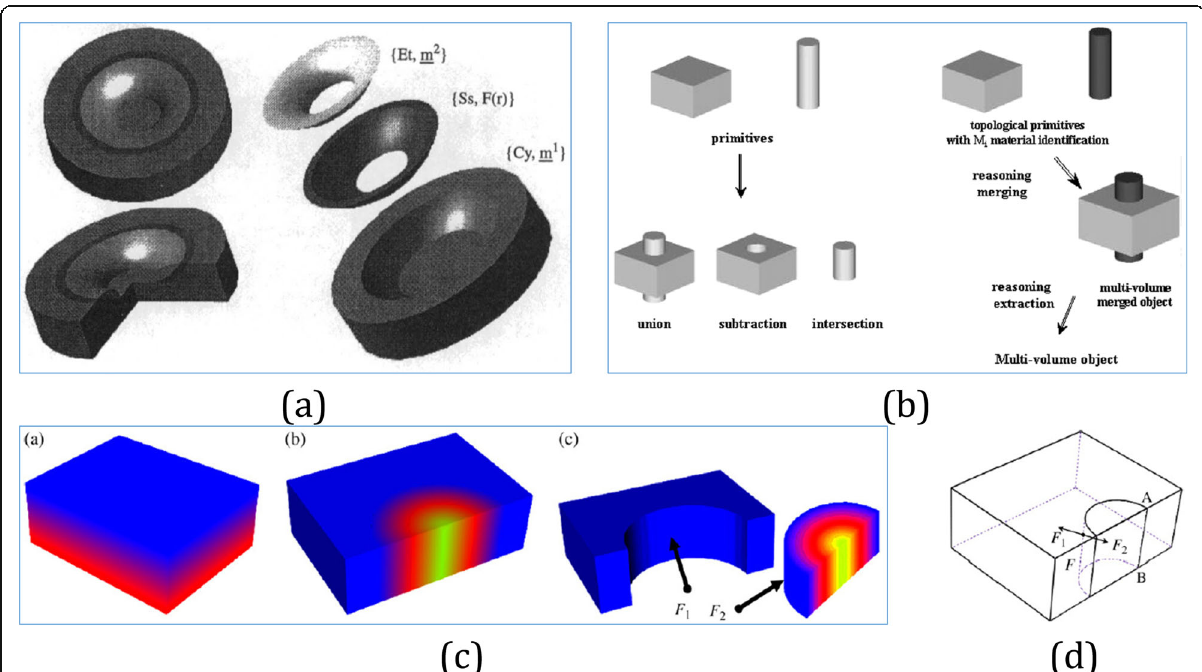
Fig. 8 a Heterogeneous object made of simple material distribution sampled with the composition changing linearly from one material region to another [73]. b Comparison of conventional (left) and reasoning (right) boolean operations for heterogeneous objects modeling [74]. c When hybrid homogeneous, unidirectional or trivariate FGM distributions might occur in the same part, composite models are ideal to represent such objects. With the cellular model in ( d ), the delimiting face is no longer separately represented as shown in ( c )